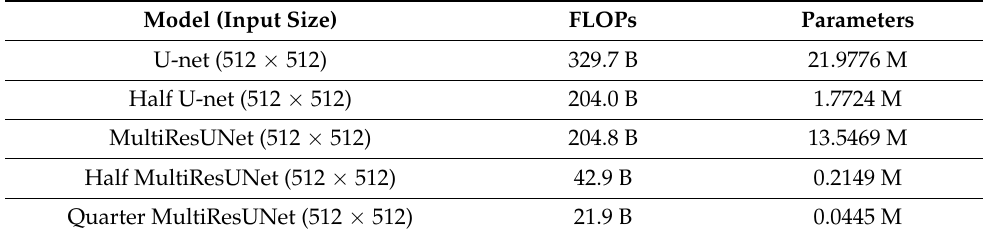
Table 4. Required FLOPs and the number of parameters for five